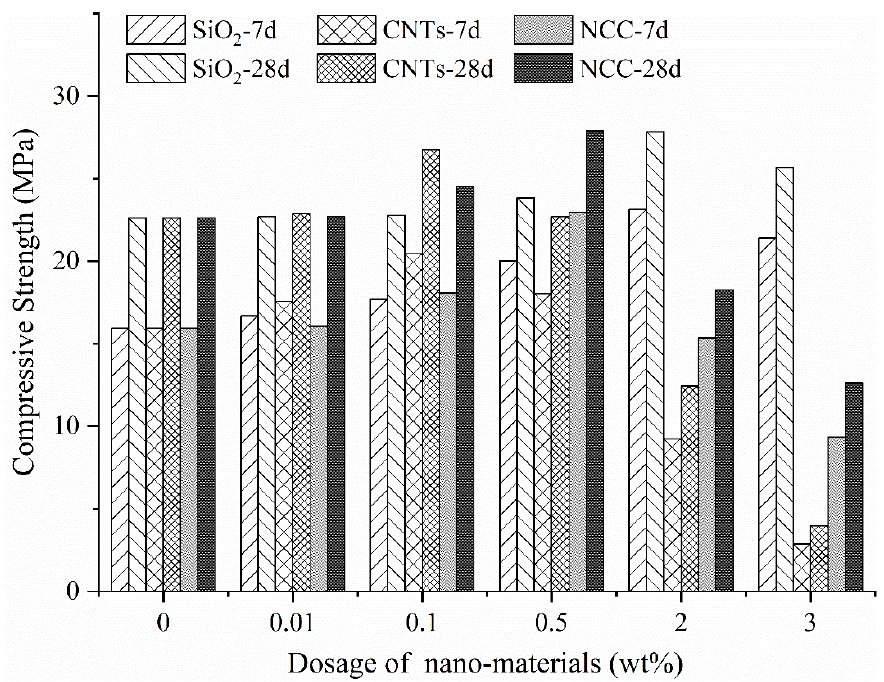
Figure 1. Effect of nanomaterial content on compressive strength. Figure 1. E ff ect of nanomaterial content on compressive